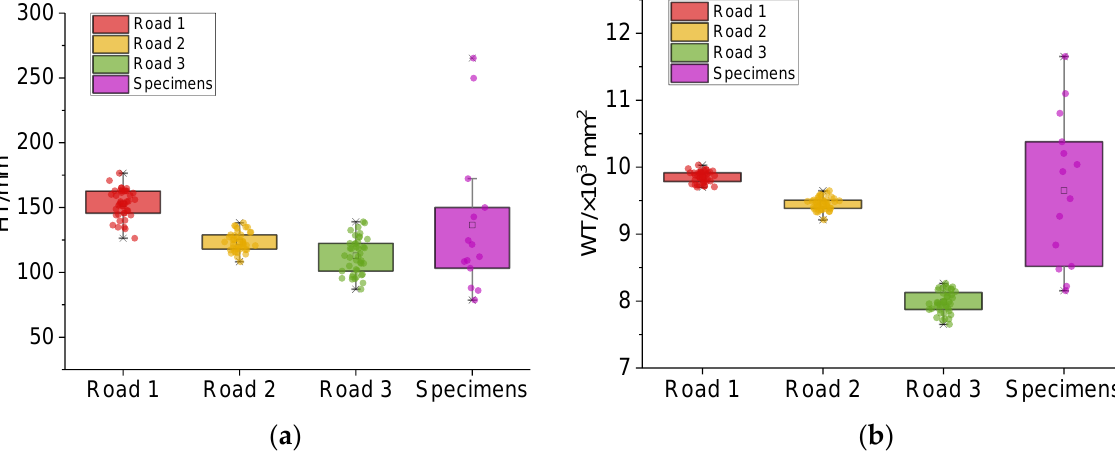
Figure 10. Areas under the PSD curve for macro-texture and micro-texture of different roads and specimens. ( a ) HT s of different roads and specimens. ( b ) WT s of different roads and specimens.